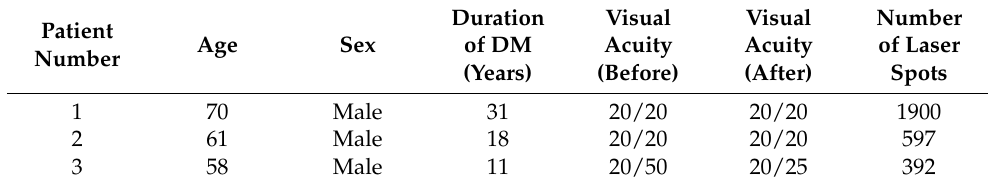
Table 1. Clinical data of patients.